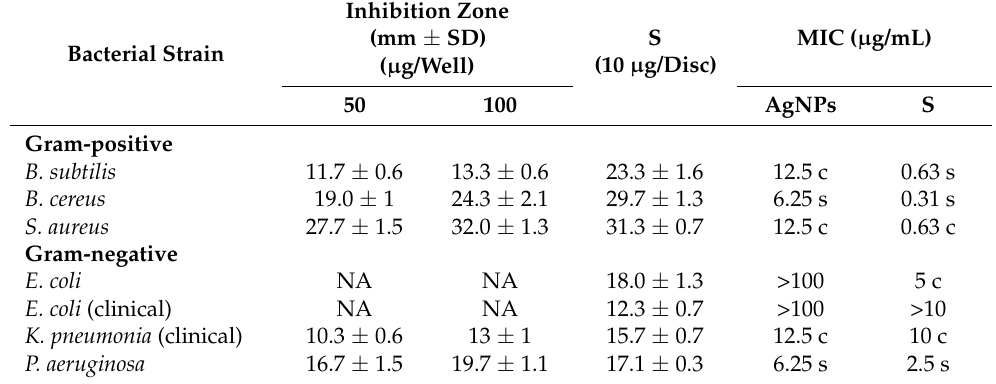
Bacterial Strain